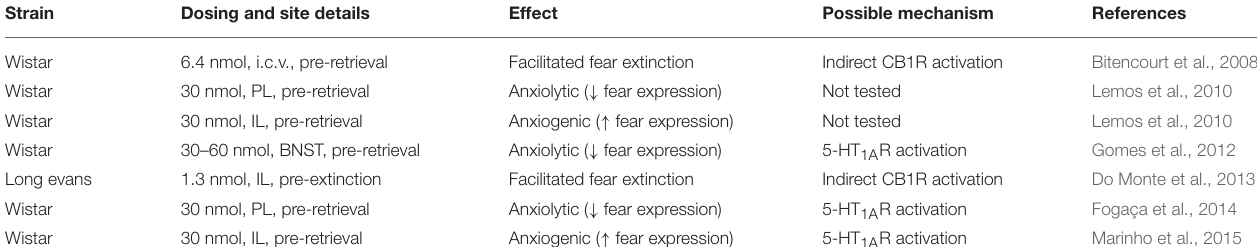
TABLE 2 | Summary of central CBD effects on contextual fear memory processing in male rats (5-HT 1A R, serotonin1A receptor; BNST, bed nucleus of the stria terminalis; CB1R, cannabinoid type1 receptor; i.c.v., intracerebroventricular; IL, infralimbic; i.p., intraperitoneal; PL, prelimbic).